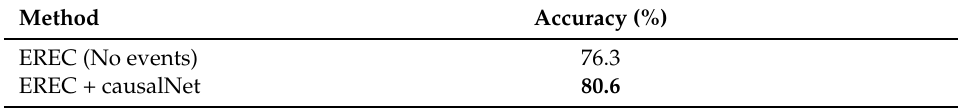
Table 2. Ablation